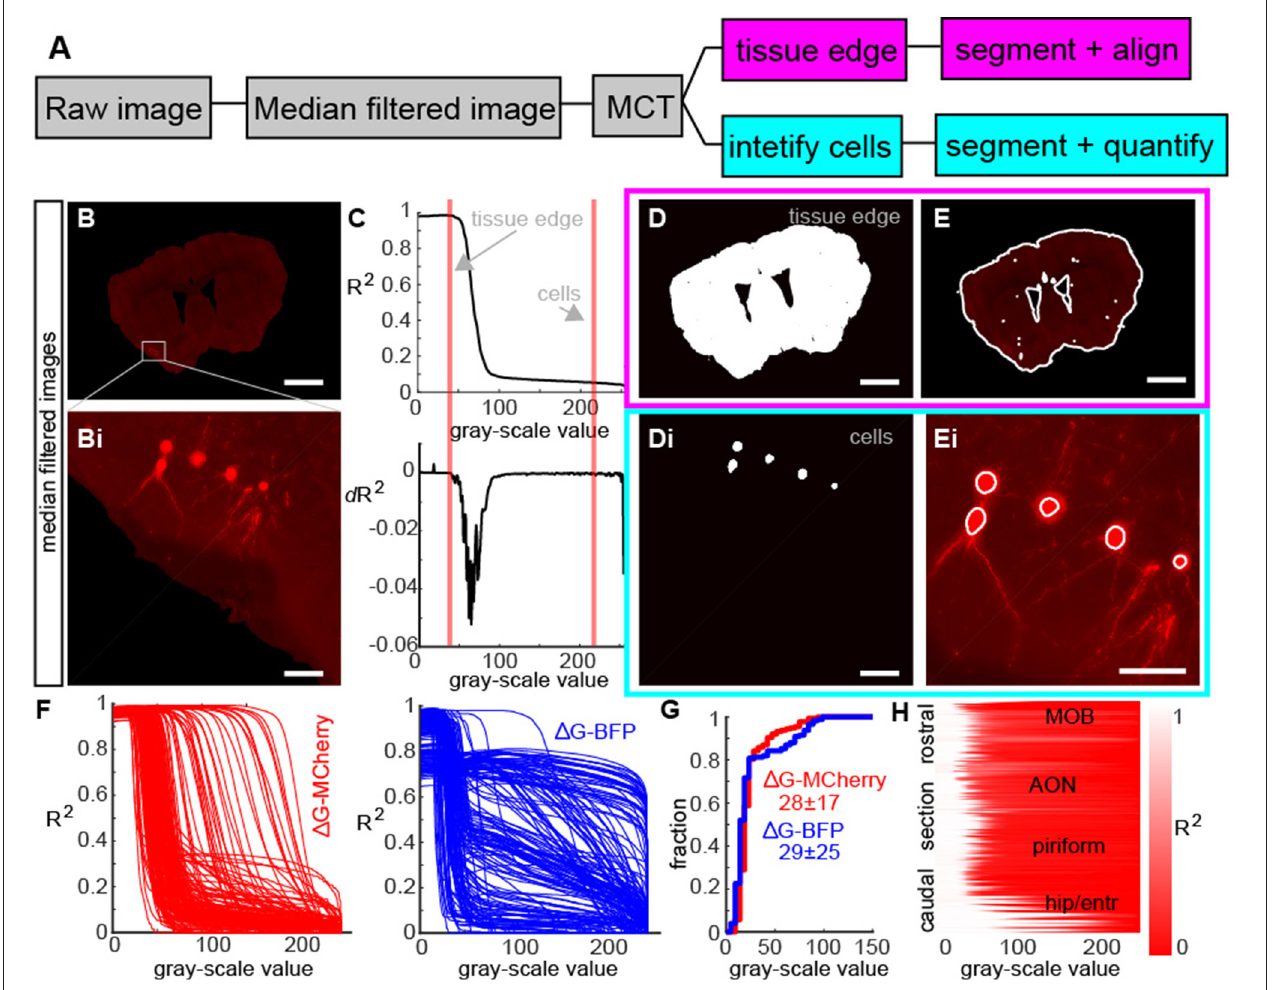
FIGURE 2 | Image processing steps for whole brain reconstructions. (A) Flow diagram of image processing for identifying tissue structure and neurons. (B) Representative example of a median filtered fluorescence image section and (Bi) enlargement of retrogradely labeled neurons showing blurring of cell bodies due to filtering. ( C , top) Correlation of a thresholded image to the median filtered image as a function of threshold value and ( C , bottom) derivate of correlation curve. Red lines show transitions in the image statistics that correspond to the tissue edge which identifies the section boundaries and labeled cells. (D) Example of thresholded images from A at the values corresponding to the tissue edge and (Di) to retrogradely labeled neurons. (E) Outline of tissue edge and (Ei) individual cells shows that the algorithm identifies both the sections in the imaging and individual neurons. (F) Correlation curve (as described in C ) for all sections in an experiment using G-MCherry (left) and G-BFP show the diversity of threshold functions across different sections and different viral constructs. (G) Cumulative histogram of threshold values selected for each section in (F) for G-MCherry and G-BFP highlight this diversity. (H) Correlation curves as a function of rostral-caudal axis shows a systematic variation from the olfactory bulb to the hippocampus and entorhinal cortex, reflecting the ability of the algorithm to segment sections and identify cells across the systematic differences in fluorescence associated with different